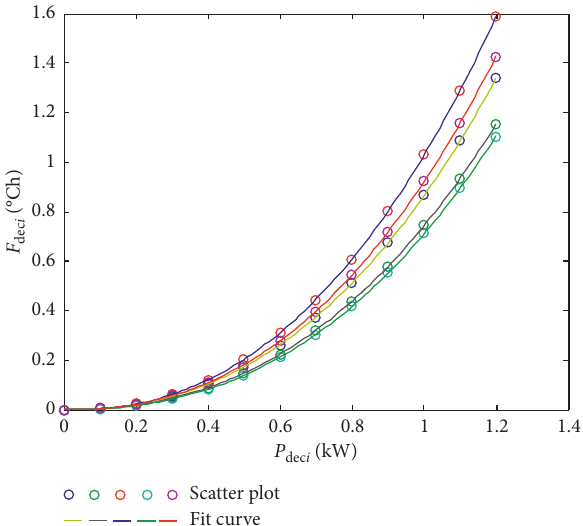
Figure 6: Scatter plot and fit curve of P